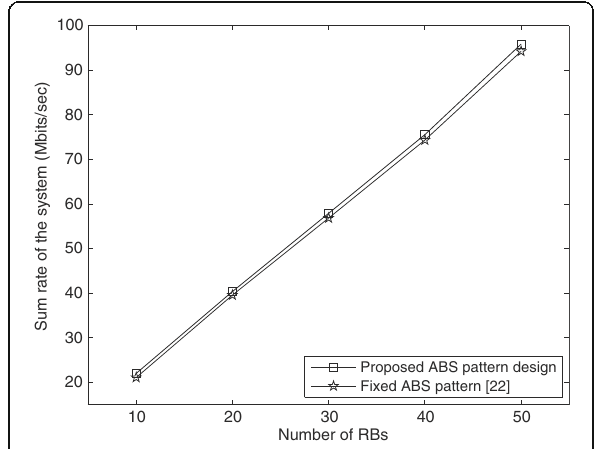
Fig. 3 Comparison of the proposed ABS pattern design with the fixed ABS pattern. The sum rate of the system versus the number of RBs with the number of UEs K = 24 and the bias value = 8